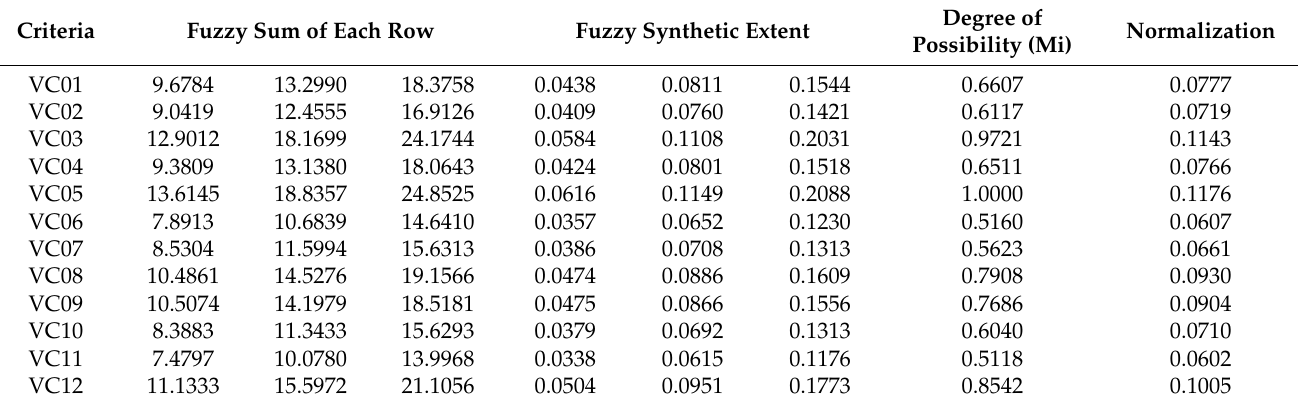
Table 2. Results of the FAHP model.